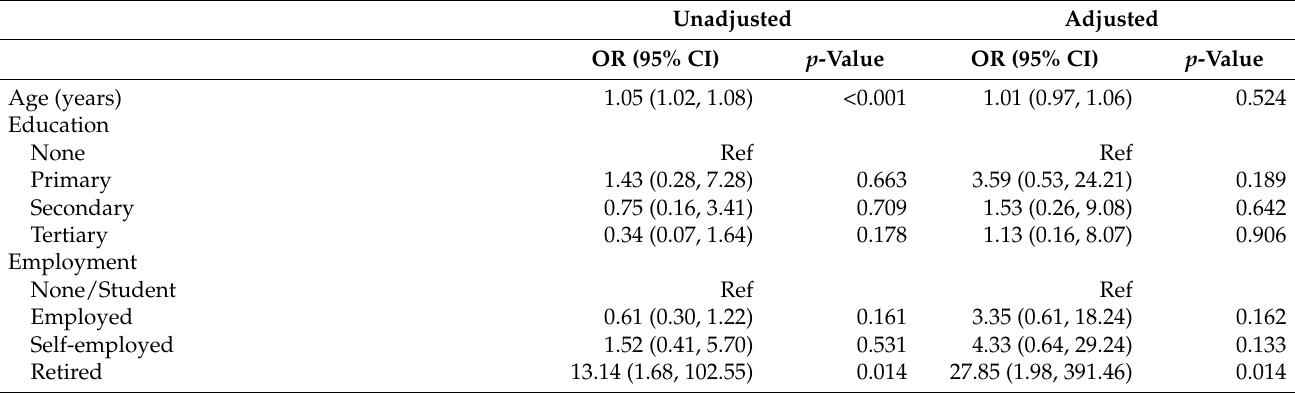
Table 4. Multivariable logistic regression of adherence on significant factors from bivariate analysis. Variables with p -values < 0.1 from the chi-square tests compared to adherence. Dependent